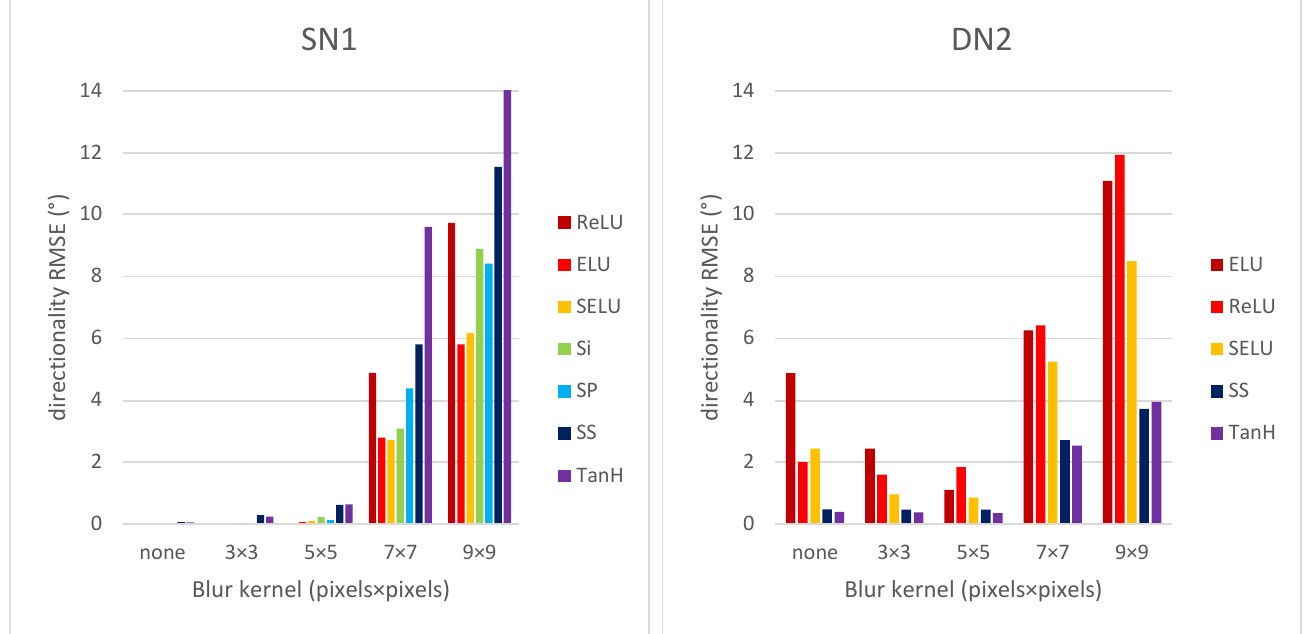
Figure 7. Directionality RMSE for CNNs SN1 and DN2 vs. blur kernel size. Both shallow and deep CNNs are sensitive to blurring for kernel size 7 × 7 and beyond. As before, the best performing activation functions for the shallow CNN are ELU and SELU, whereas for the deep CNN are TanH and SS.